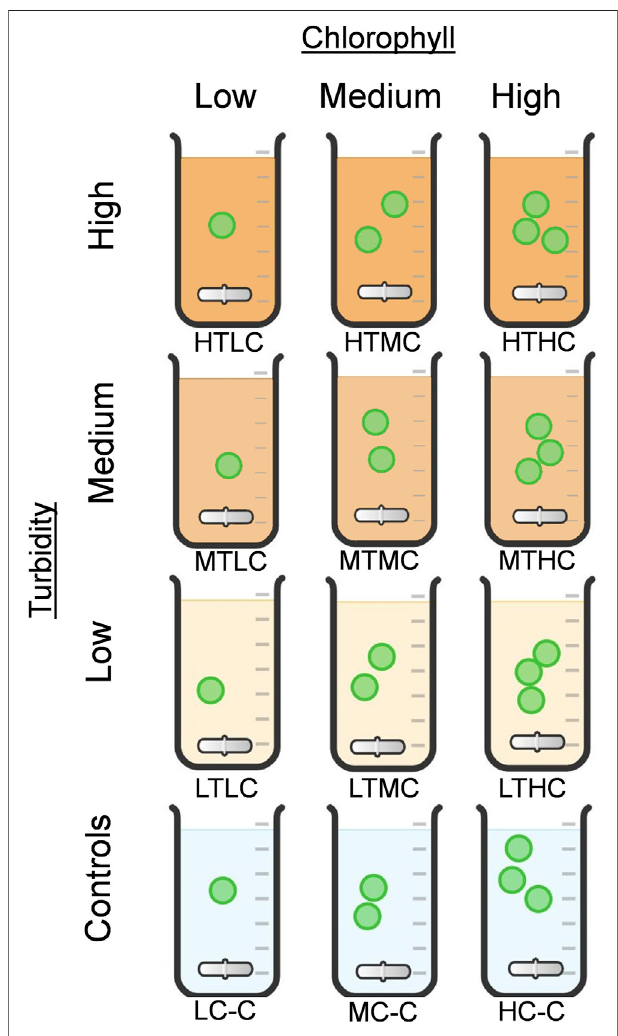
FIGURE 1 | Experimental design: combinations of three chlorophyll levels (Low, Medium, High) and turbidity (Low, Medium, High), forming nine categories of triplicate treatments including controls. HT: High Turbidity; MT: MediumTurbidity;LT:LowTurbidity;HC:HighChlorophyll;MC:Medium Chlorophyll; LC: Low